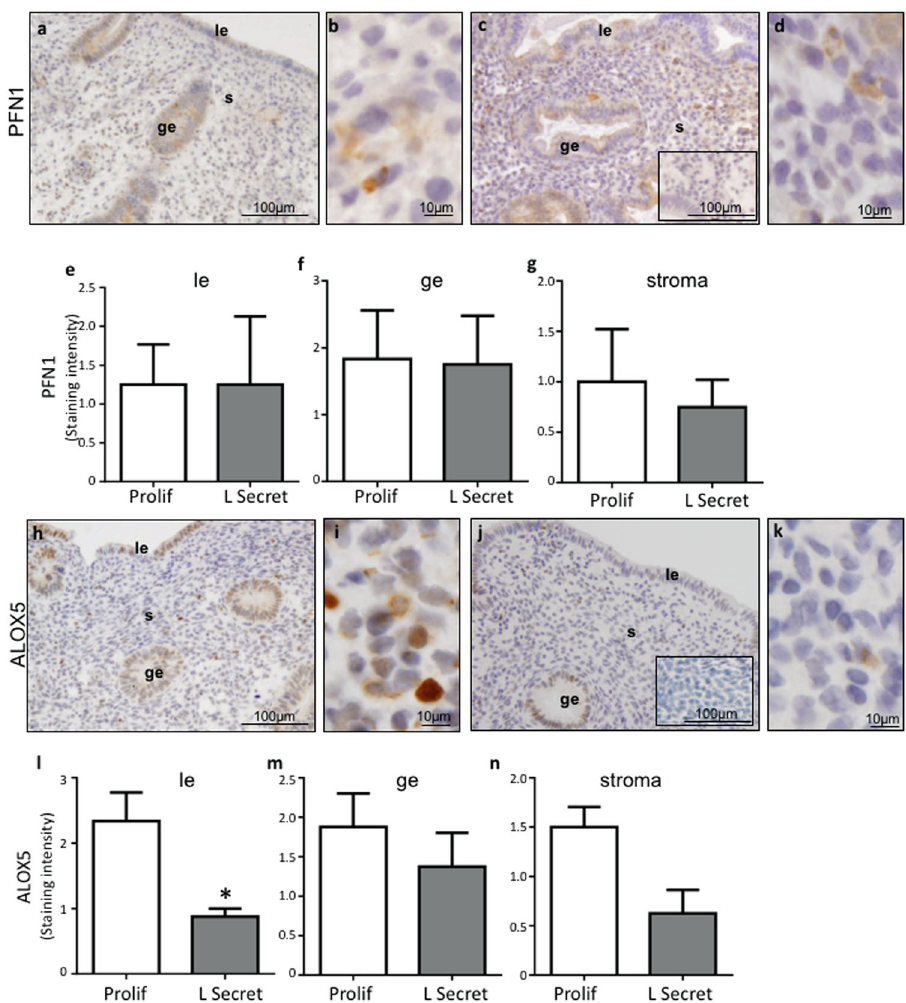
Figure 4. PFN1 and ALOX5 immunolocalization in endometrium. ( a–d) Representative photomicrographs of endometrial biopsies showing localization of PFN1 protein in the stroma (s), luminal (le) and glandular (ge) epithelium in the proliferative ( a,b ) and late secretory ( c,d ) phases. ( e–g) PFN1 immunostaining intensity scoring in the luminal epithelium (e, n = 3), glandular epithelium (f, n = 3) and stroma (g, n = 3). ( h–k ) Representative photomicrographs of endometrial biopsies showing localization of ALOX5 protein in the stroma, luminal and glandular epithelium in the proliferative ( h–i ) and late secretory ( j–k ) phases. ( l–n ) ALOX5 immunostaining intensity scoring in the luminal epithelium (l, n = 4), glandular epithelium (m, n = 4) and stroma (n, n = 4). Inserts show negative staining. Data are mean ± SEM, * p < 0.05, significant difference from proliferative phase; e-g;l-n: Mann Whitney